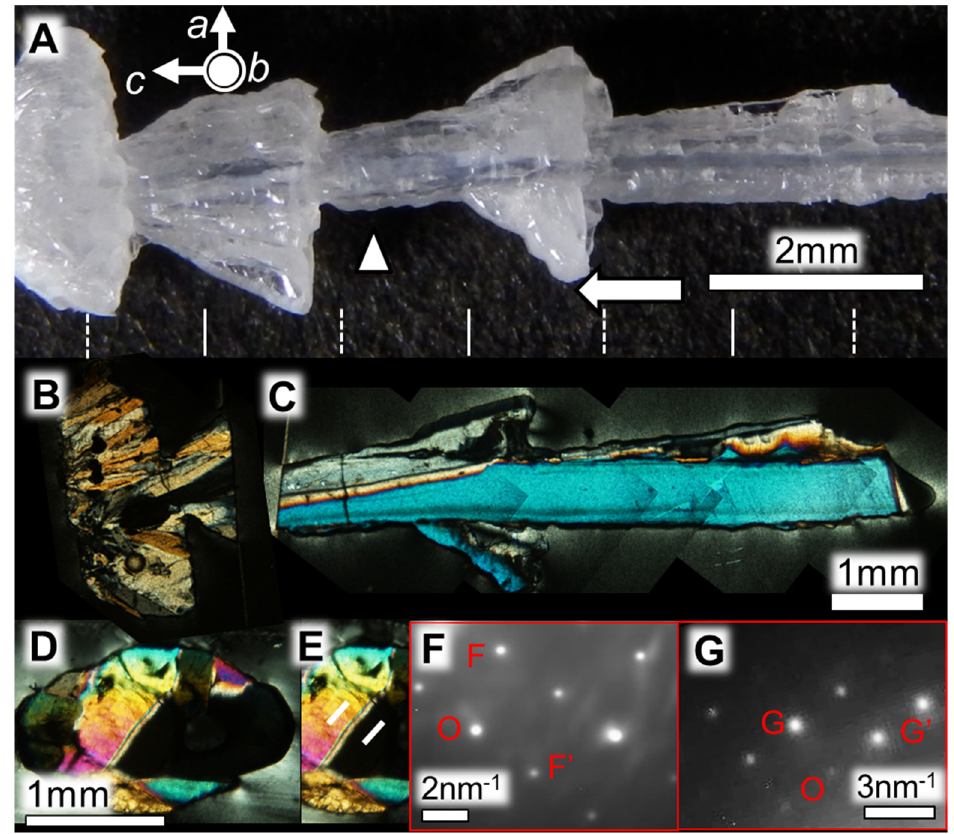
Figure A2. SBO crystal fibers grown at 1400 V/cm: ( A ) external form of SBO crystal fibers; ( B , C ) polarized optical microscope image of the SBO crystal taken under crossed Nicols; ( D ) cross-sectional view of the crystal fiber at the white arrowhead position of ( A ) ( A portion between ( B , C )); ( E ) parts processed by FIB for the TEM/SAED observation (white lines); ( F ) electron diffraction pattern at the left of ( E ); ( G ) electron diffraction pattern at the right of ( E ). Symbols in ( A ) correspond to the crystallographic orientation of seed crystals. A white arrow corresponds to the pulling-down direction. Alternating timing of electric fields was drawn by solid lines (electrodes in the melt, +; growth fronts, − ) and dashed lines (electrodes in the melt, − ; growth fronts, +).